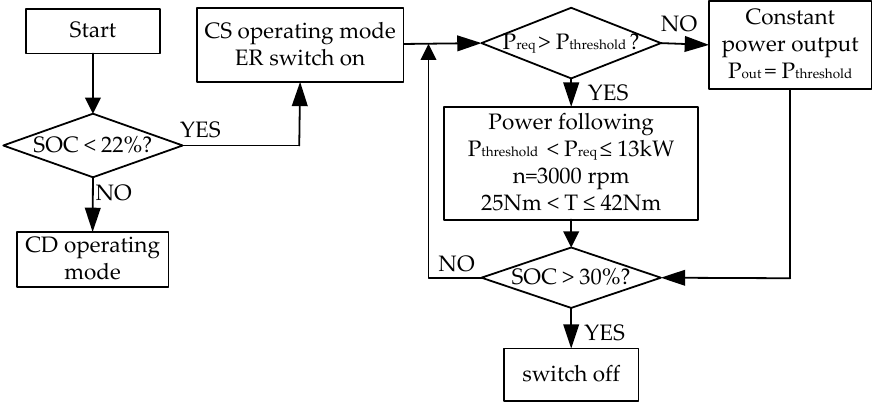
Figure 6. State chart of the partial power following strategy.